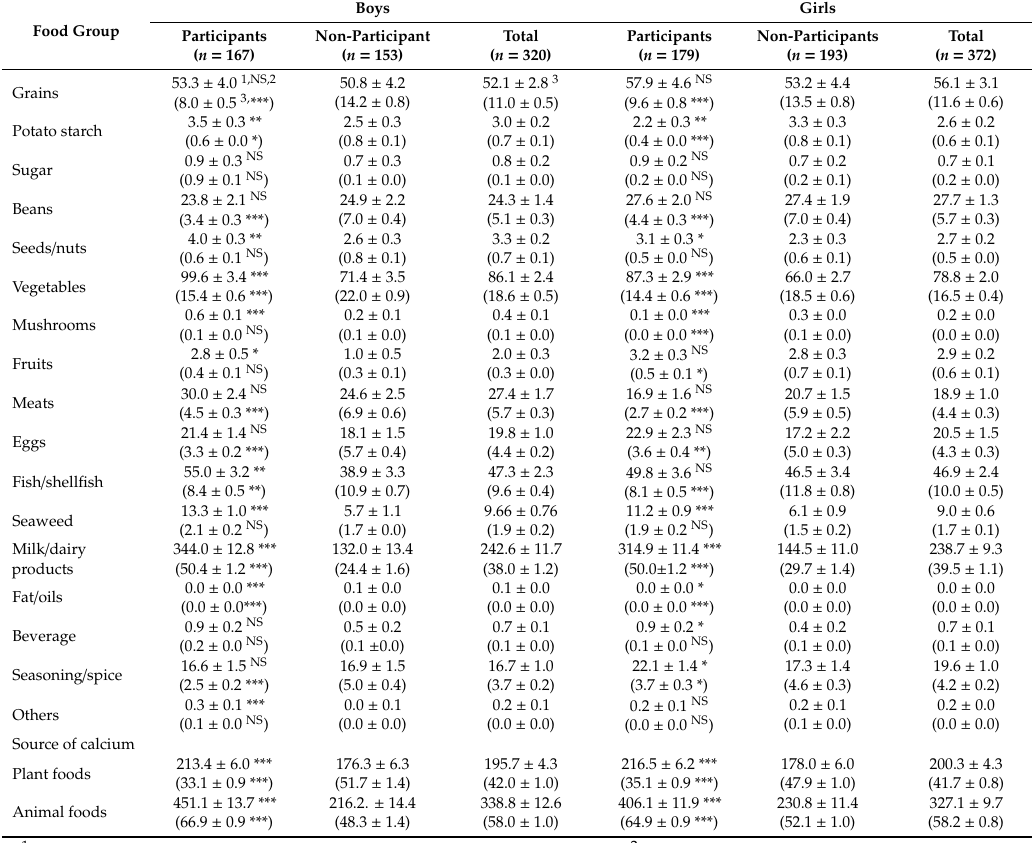
Table 5. Amounts and percentages of daily calcium intake by food group of participants and non-participants in the school milk program in South Korea (mg / d